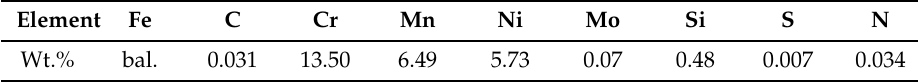
Table 2. Chemical composition of CrMnNi-TRIP-steel.